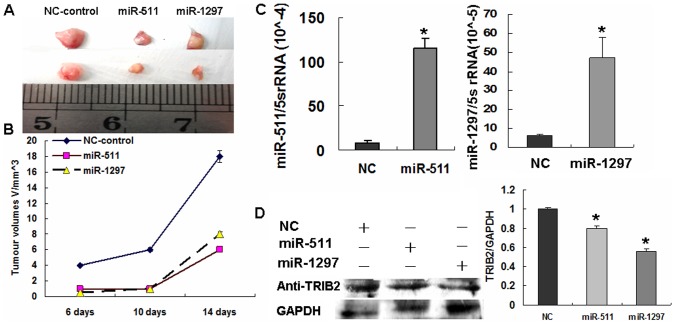
Detection of A549 lung cancer xenografts into nude mice.(A) Tumor tissues were removed and measured 15 days after engraftment. (B) Growth curve was drawn from measurement taken 6 days after xenograft (n = 4 each group). From A and B, A549 cell xenografts were inhibited and smaller tumor volumes were detected in miR-511- and miR-1297-treated tumors compared with the NC-treated tumors. (C) Real-time PCR detection. After isolation of miRNAs from xenografts, higher miR-511 and miR-1297 levels were found in the miR-511- and miR-1297-treated xenografts than controls. (D) Western blotting detection. TRIB2 expression was detected in xenografts and the results showed that its expression in the miR-511- and miR-1297-treated xenografts was lower than that of NC-treated controls (*p<0.05). Relative values for TRIB2 vs GAPDH are indicated to the right of the gel.